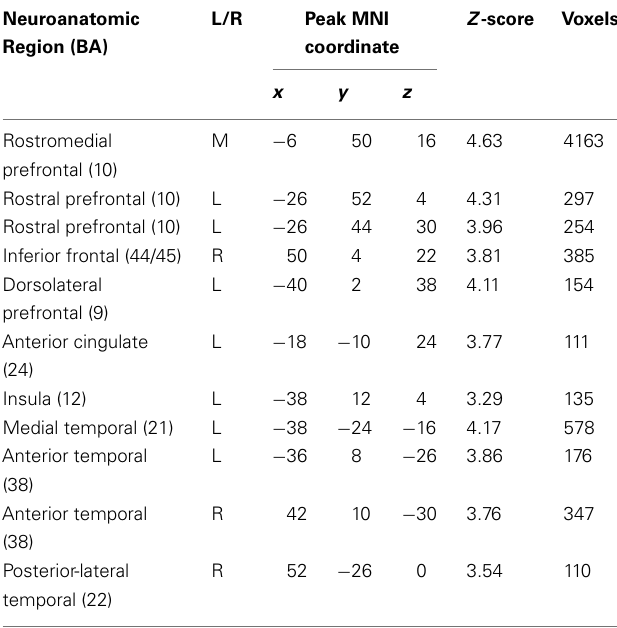
Table 3 | Regions of significantly reduced gray matter density in bvFTD patients relative to demographically matched healthy seniors ( p < 0.05 FDR-corrected; 100 voxel extent).